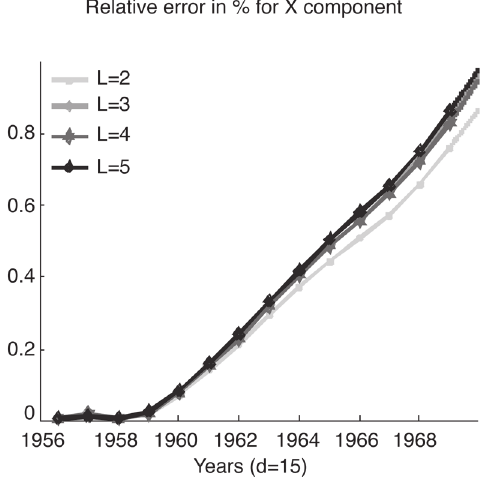
Fig. 5. Relative error prediction variation by the prediction year for different number L of